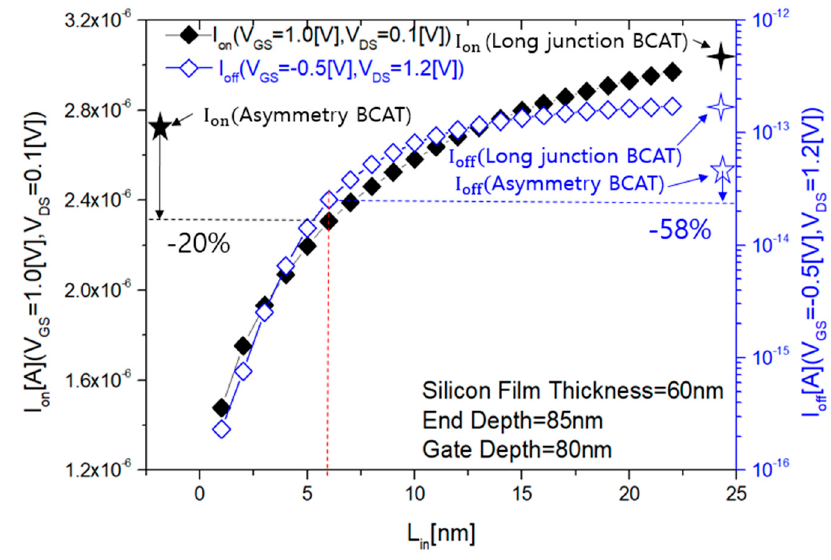
Figure 7. I on and I off according to the L in in Pi-BCAT.